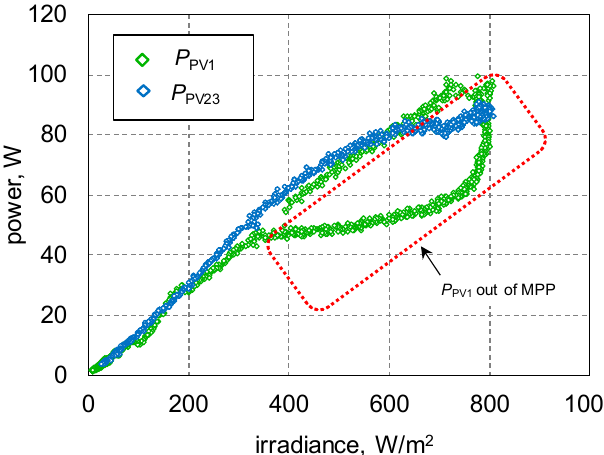
Figure 13. Power of 1 m 2 of PV panels in investigated setups as a function of irradiance.